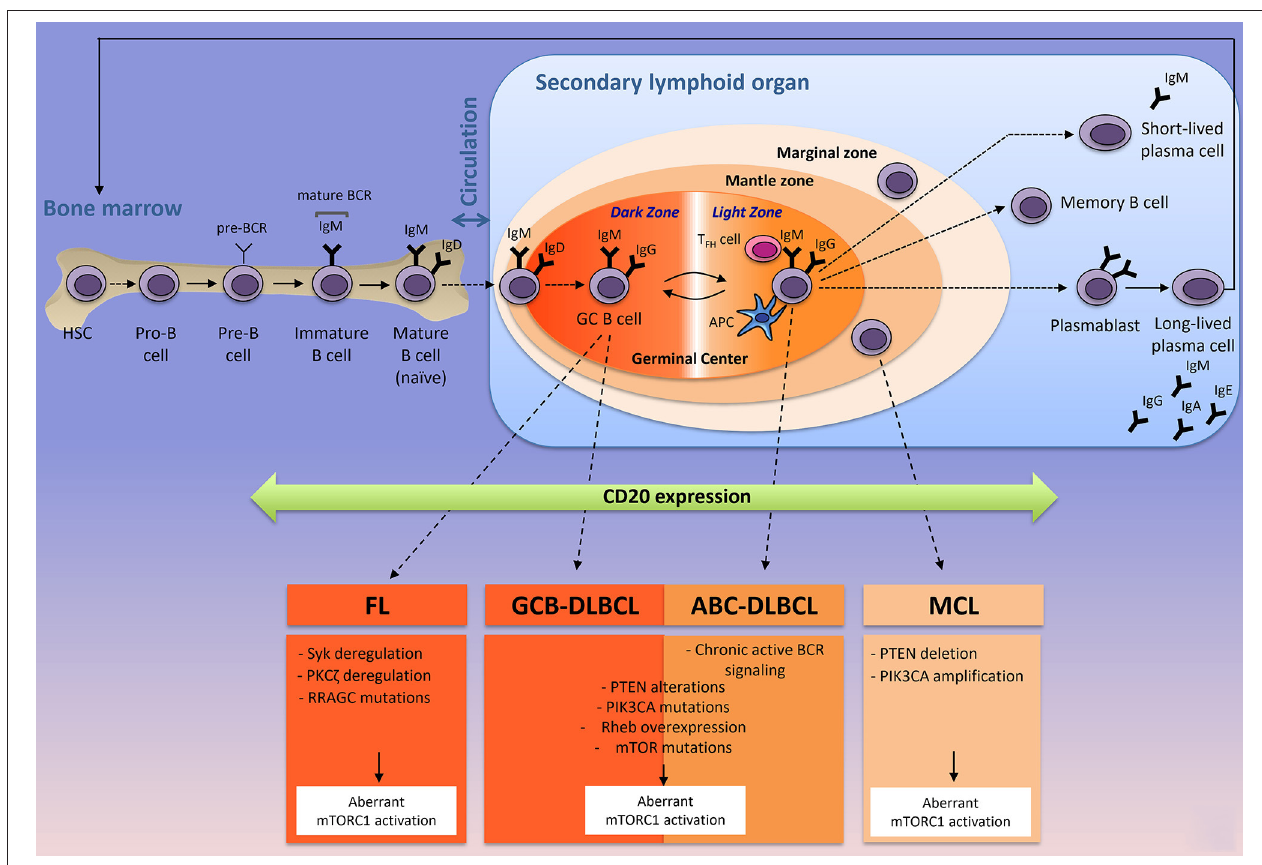
FIGURE 1 | The origin of the three most-common mature B-cell lymphoid neoplasms according to their normal B cells counterparts. Naïve B cells develop in the bone marrow where they generate a B-cell receptor (BCR) and circulate to the secondary lymphoid organs (spleen or lymph nodes) where they are activated in contact with a specific antigen, resulting in a formation of a germinal center. Antibody affinity maturation occurs in the dark zone where B cells extensively proliferate and undergo somatic mutations of the immunoglobulin variable region, and in the light zones, where B cells interact with T FH and APC cells and are selected for a specific clone that has the highest affinity for the antigen. MCL, DLBCL (ABC- and GCB-), and FL are NH B-cell lymphomas arise from mature B-cells in the secondary lymphoid organ. In most of the cases, FL, DLBCL, and MCL express the transmembrane protein CD20 (that is acquired from pre-B to memory stages), targeted by Rituximab (anti-CD20) and harbor different intrinsic factors leading to a constitutive mTORC1 activity. Corresponding intrinsic factors leading to aberrant mTORC1 activation are indicated. APC, antigen presenting cell; T FH , follicular helper T cell; Ig; immunoglobulin; BCR, B-cell receptor; FL, Follicular Lymphoma; DLBCL, Diffuse Large B Cell Lymphoma; GCB-DLBCL, germinal-center B-cell-DLBCL; ABC-DLBCL, Activated B-cell-DLBCL; MCL, Mantle Cell